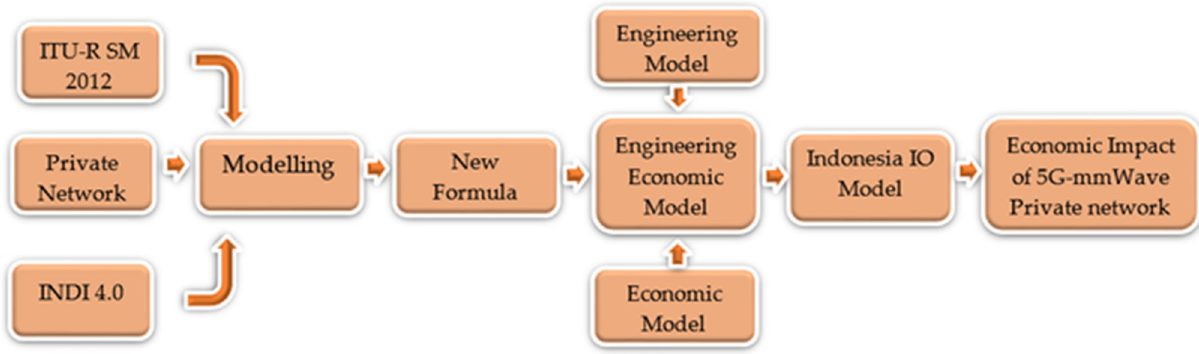
Figure 8. Indonesia spectrum usage fee model .